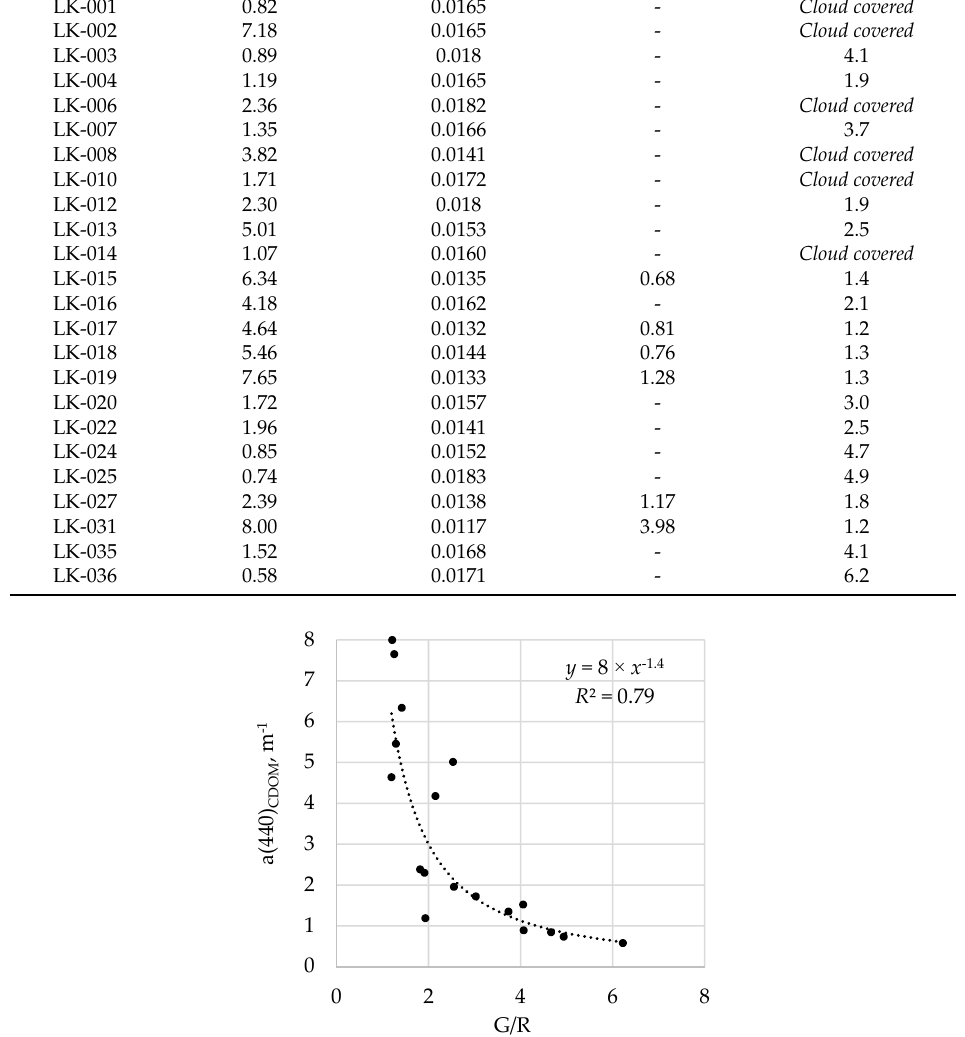
Figure 2. Comparison of measured CDOM absorption at 440 nm (2014) from the water samples versus the green reflectance/red reflectance (G/R) ratio retrieved from mosaicked GeoEye-1 5 July 2013 and WorldView-2 21 July 2013 surface reflectance data set.